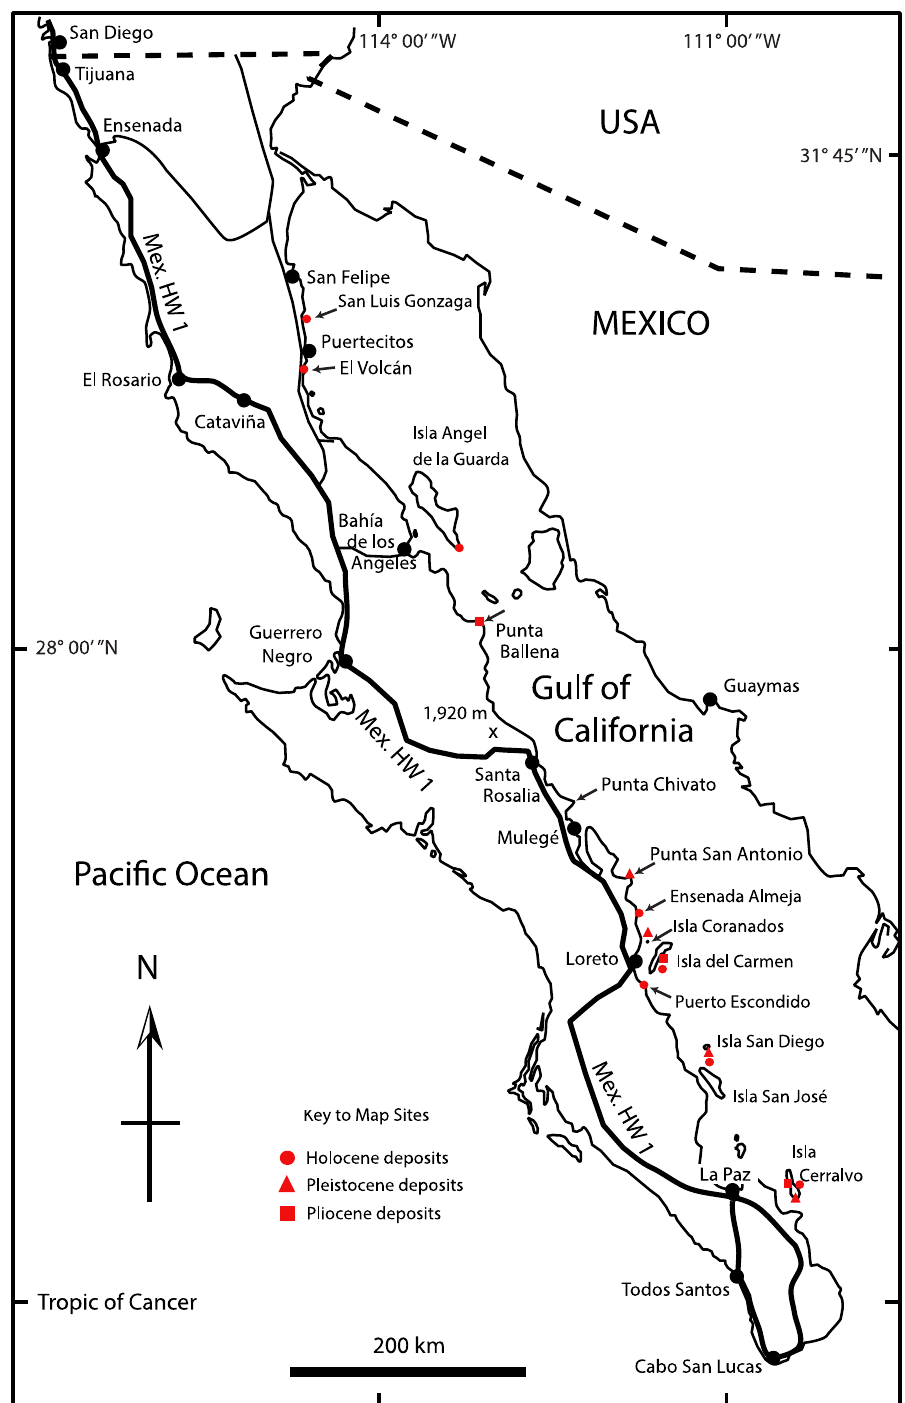
Figure 4. Mexico’s Baja California and adjacent Gulf of California showing 14 localities with storm deposits of varying ages: Pliocene (square), Pleistocene (triangle), and Holocene (circle). See Table 2 for details.